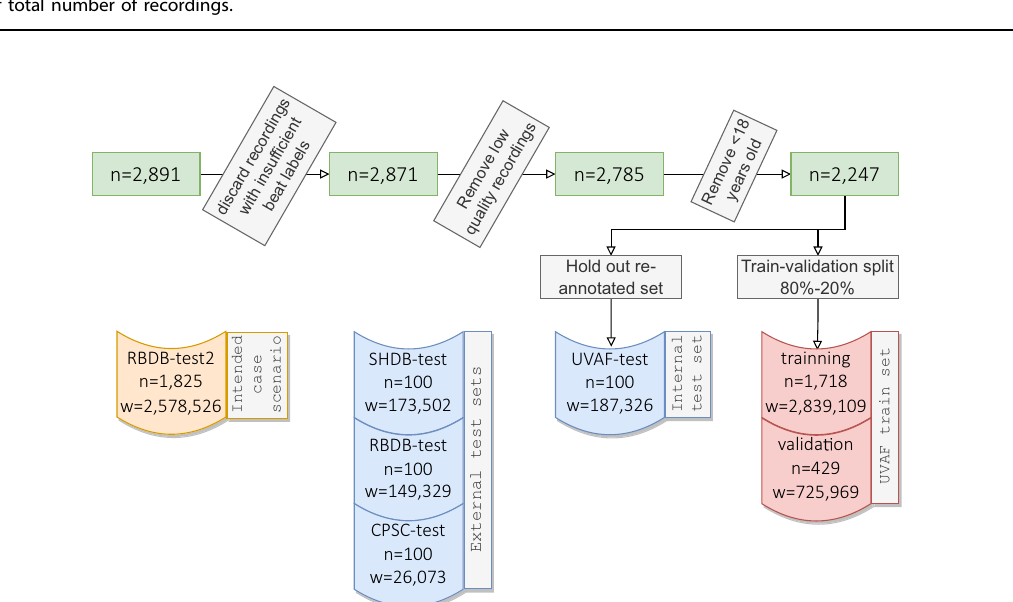
Fig. 1 Data exclusion and strati fi cation. Description of the exclusion process applied to the UVAF database and of all datasets used in this